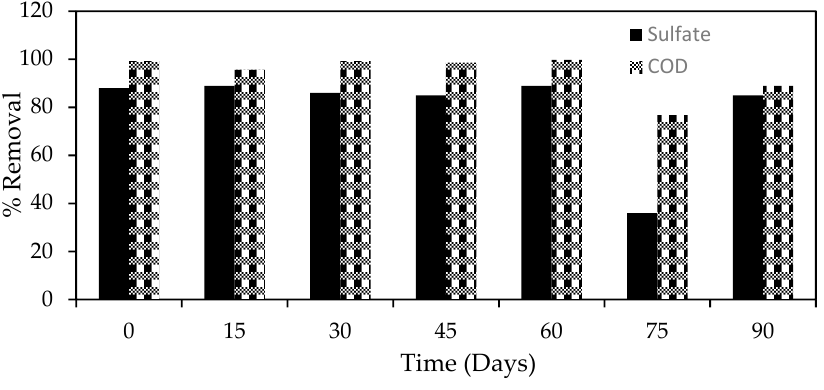
Figure 7. The removal rate for sulfate in comparison to COD.